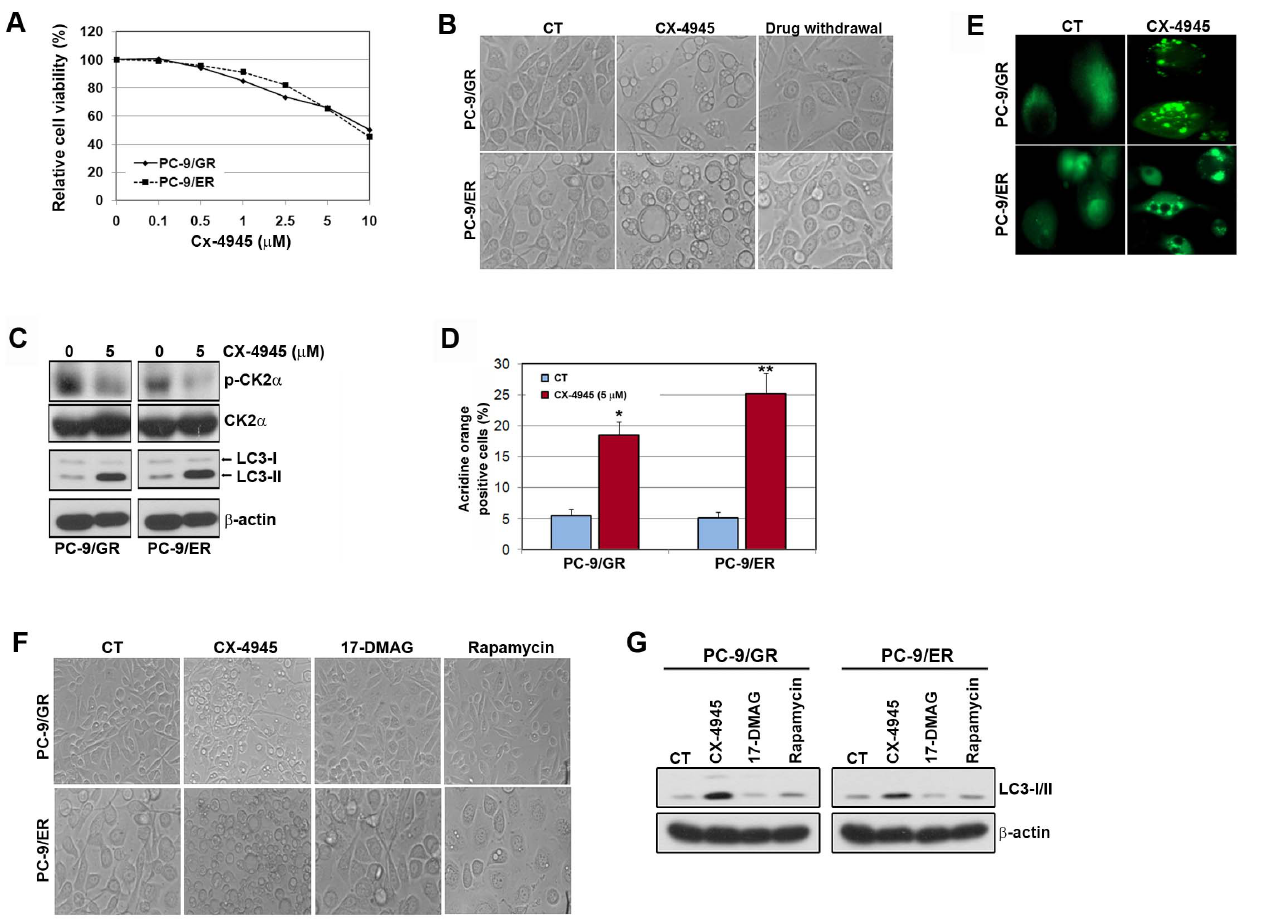
Figure 1. CX-4945 induced the autophagy in EGFR-TKI-resistant PC-9 cells. A, Cells were treated with different concentrations of CX-4945 for 72 h, and the rate of inhibition was determined by MTTassay. B, Cells were treated with or without CX-4945 (5 m M) for 48 h and were then incubated for 24 h with a drug-free medium containing 10% FBS. Pictures showing the autophagic vacuole formation (AVOs) were taken at 6 20 magnification. C and D, Cells were treated with CX-4945 for 48 h. Cell lysates were subjected to Western blot analysis. Quantitative detection of acidic vesicular organelles by acridine orange staining of cells was determined by FACS analysis. *p , 0.01 and **p , 0.001 compared with the control. E, Cells were transfected with a plasmid to express LC3-GFP. After 24 h transfection, cells were treated with CX-4945 (5 m M) for 24 h. Punctate pattern of LC3 localization analyzed by immunofluorescence microscopy. F and G, Cells were incubated with CX-4945 (5 m M), 17-DMAG (100 nM) or rapamycin (20 m M) for 48 h. Pictures were taken at 6 20 magnification. The induction of LC3-I/II was shown by Western blot